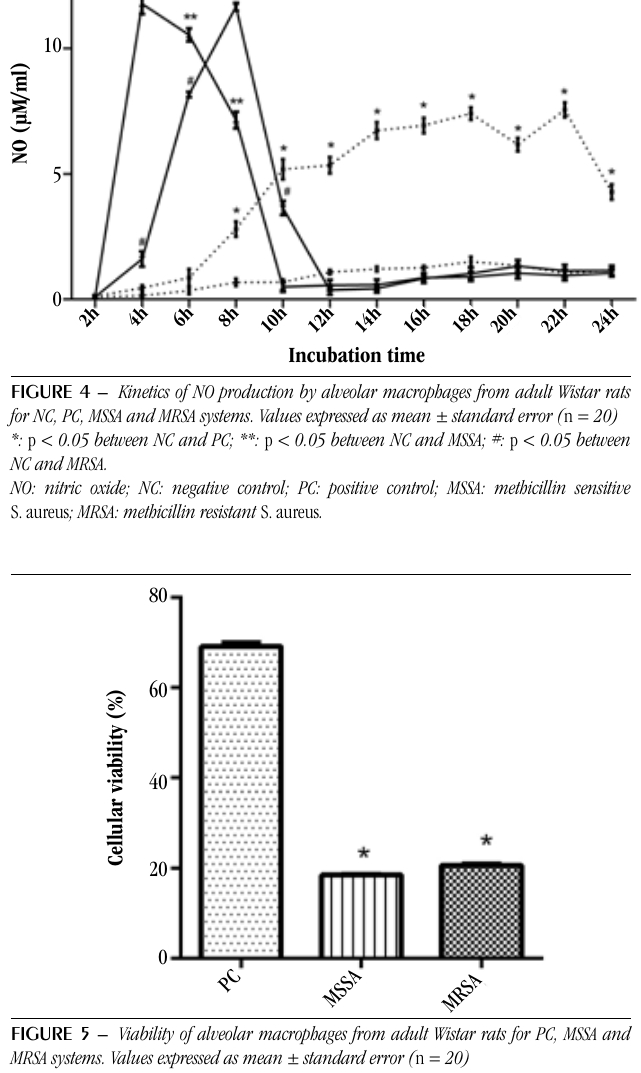
figurE 5 – Viability of alveolar macrophages from adult Wistar rats for PC, MSSA and MRSA systems. Values expressed as mean ± standard error ( n = 20) *: p < 0.05 among PC, MSSA and